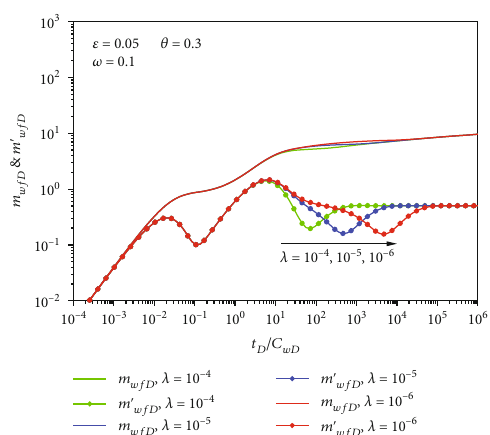
Figure 13: The in fl uence of interporosity fl ow factor.